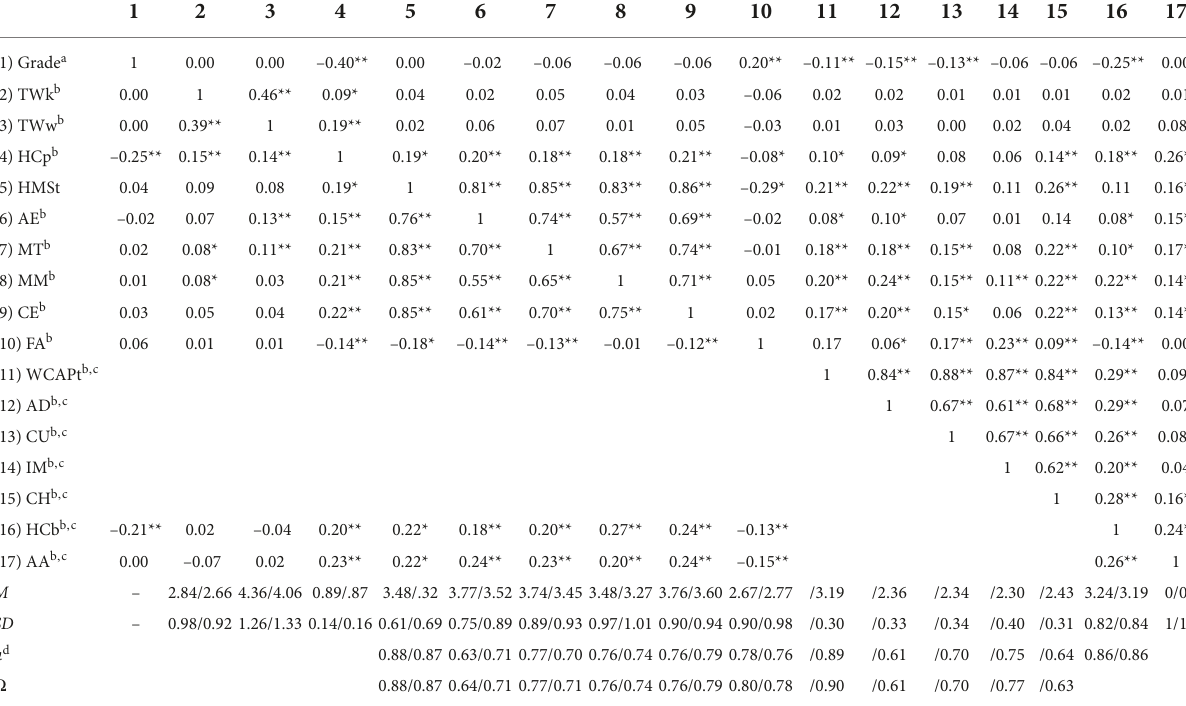
TABLE 3 Correlation matrix between variables included and the corresponding descriptive statistics.